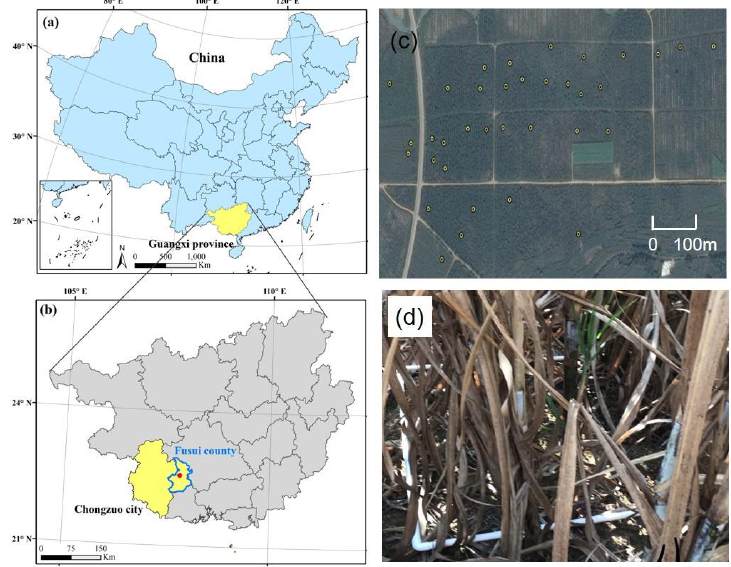
Figure 1. Study area and sampling plots. ( a ) The location of the Guangxi province in China; ( b ) Detailed map of the experimental site in Fusui county of Chongzuo city. The red dot is the field sampling area. ( c ) Spatial distribution of the field measurement sites. ( d ) An example of a 1 m × 1 m field plot. The white part is the sampling frame.